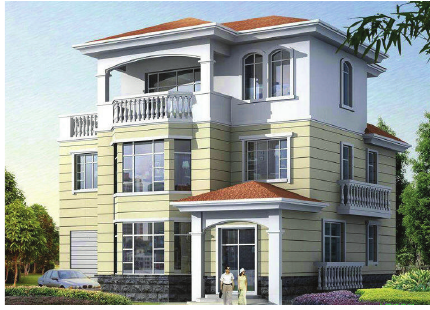
Figure 2: A three-story house as a study